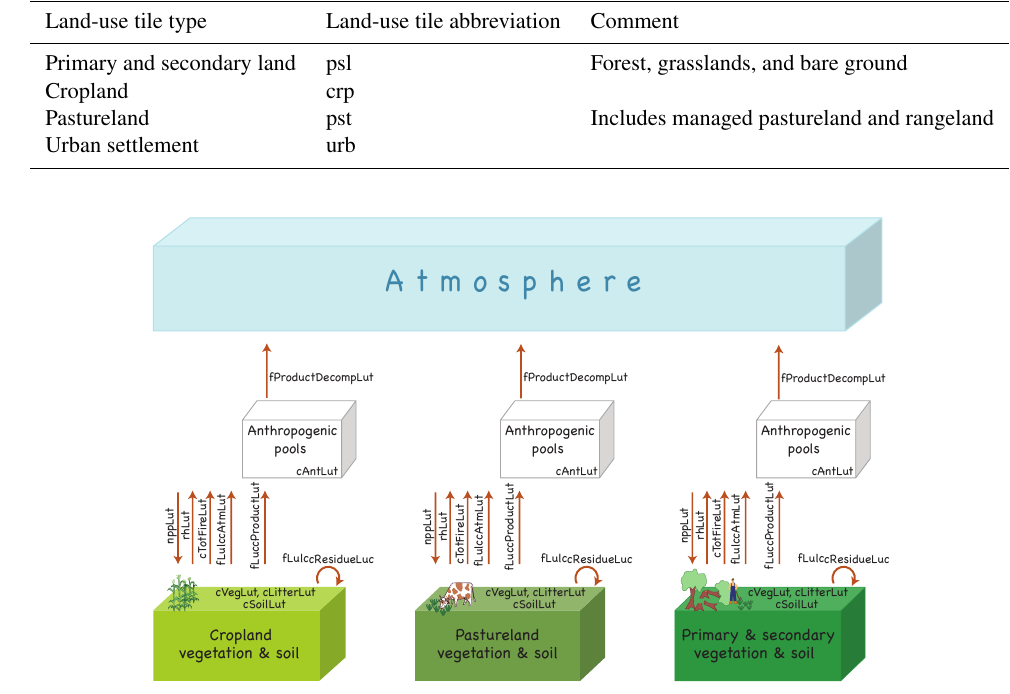
Figure 8. Exchanges and transfers affecting storage of biogeochemical constituents in land models under LULCC. Variable descriptions can be found in Table 5. Urban tile not shown, but if carbon fluxes are calculated on a particular model’s urban tile, then these fluxes should be reported for the rban tile as